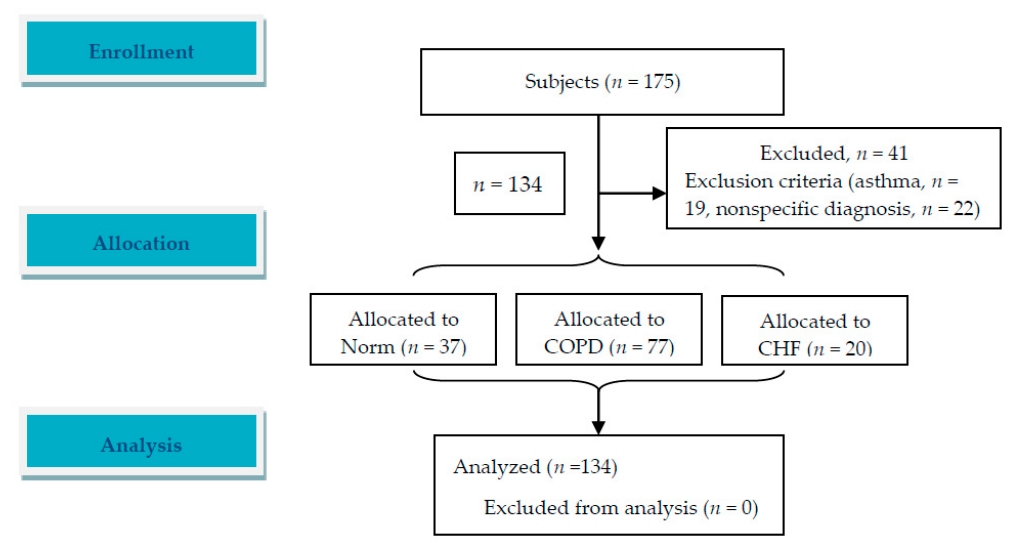
Figure 1. An image of flow diagram. A total of 175 subjects were screened and 134 patients were enrolled and analyzed. Follow-up was not applicable in this study. Table 1. Demographic data, symptom scores, lung function and oxyhemoglobin saturation measured with pulse oximetry (S P O 2 ) and oxygen uptake (VO 2 ) at rest. Group Normal